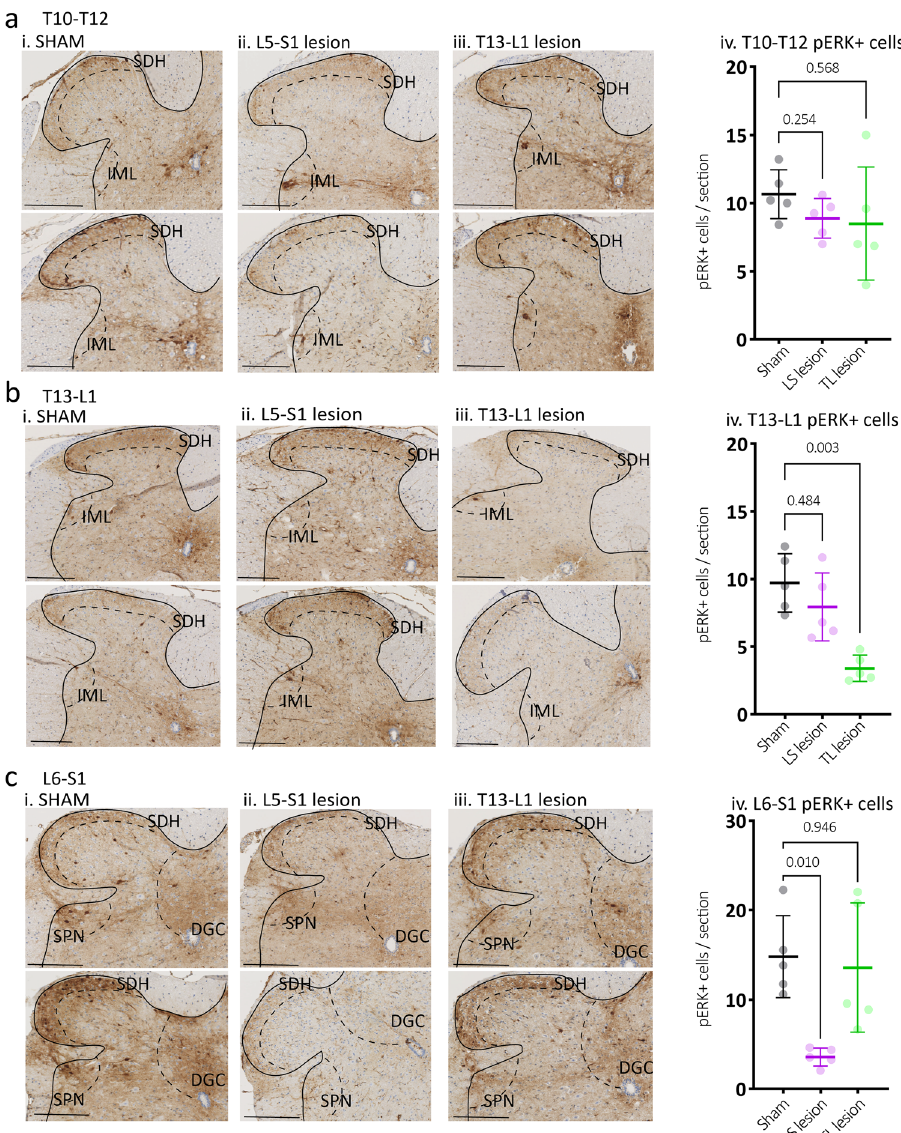
Fig. 7 Expression of cell activation marker pERK in the dorsal horn of the spinal cord following noxious colorectal distension. Representative images of pERK-immunoreactive (-IR) (dark brown) nerve cell bodies, evoked by noxious in vivo colorectal distension in cross-sections of ( a ) T10 – T12, ( b ) T13-L1, and ( c ) L6-S1 spinal cord dorsal horn from (i) Sham, (ii) LS lesion and (iii) TL lesion mice. Calibration, 100 µ m. In sham mice, pERK-IR neurons were observed in the super fi cial dorsal horn laminae I and II (SDH) at all spinal levels and below this in the in deep dorsal horn lamina (LIII-IV) in the L6-S1 spinal cord. pERK-IR neurons were present in the dorsal grey commissure (DGC), in the intermediolateral nuclei (IML) in thoracic T10 – T12 sections and in the sacral parasympathetic nuclei (SPN) in sacral sections. iv The number of pERK-IR neurons evoked by in vivo colorectal distension was quanti fi ed within sections of ( a ) T10 – T12, ( b ) T13-L1, ( c ) L6-S1 spinal cord dorsal horn from sham (grey markers), TL lesion (green markers) and LS lesion mice (magenta markers). The mean number of pERK-IR neurons/section in the T10 – T12 dorsal horn did not differ between experimental groups ( N = 5 per